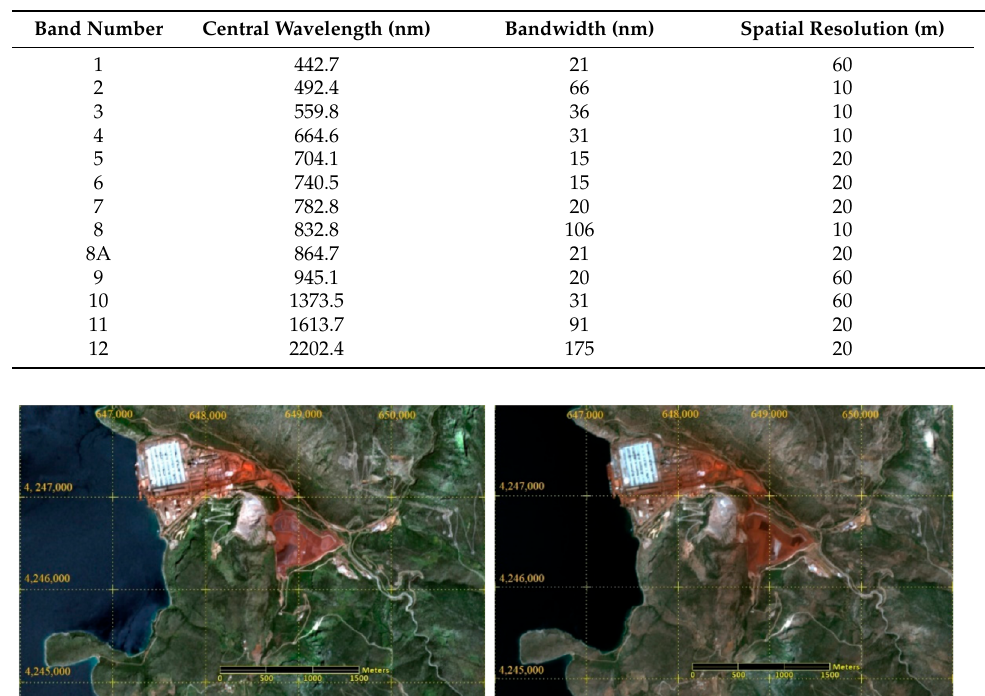
Table 3. Spectral bands for the Sentinel-2 sensor; the Bandwidth (nm) is measured at Full Width Half Maximum (FWHM) [31].